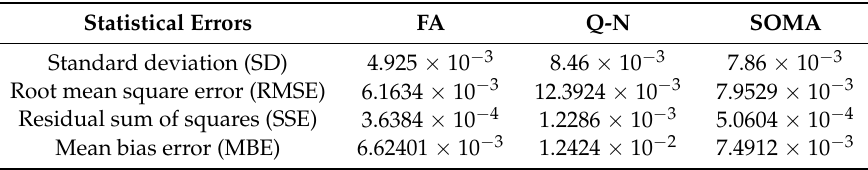
Table 11. Performance indexes of flexile silicon a-Si:H solar cell.